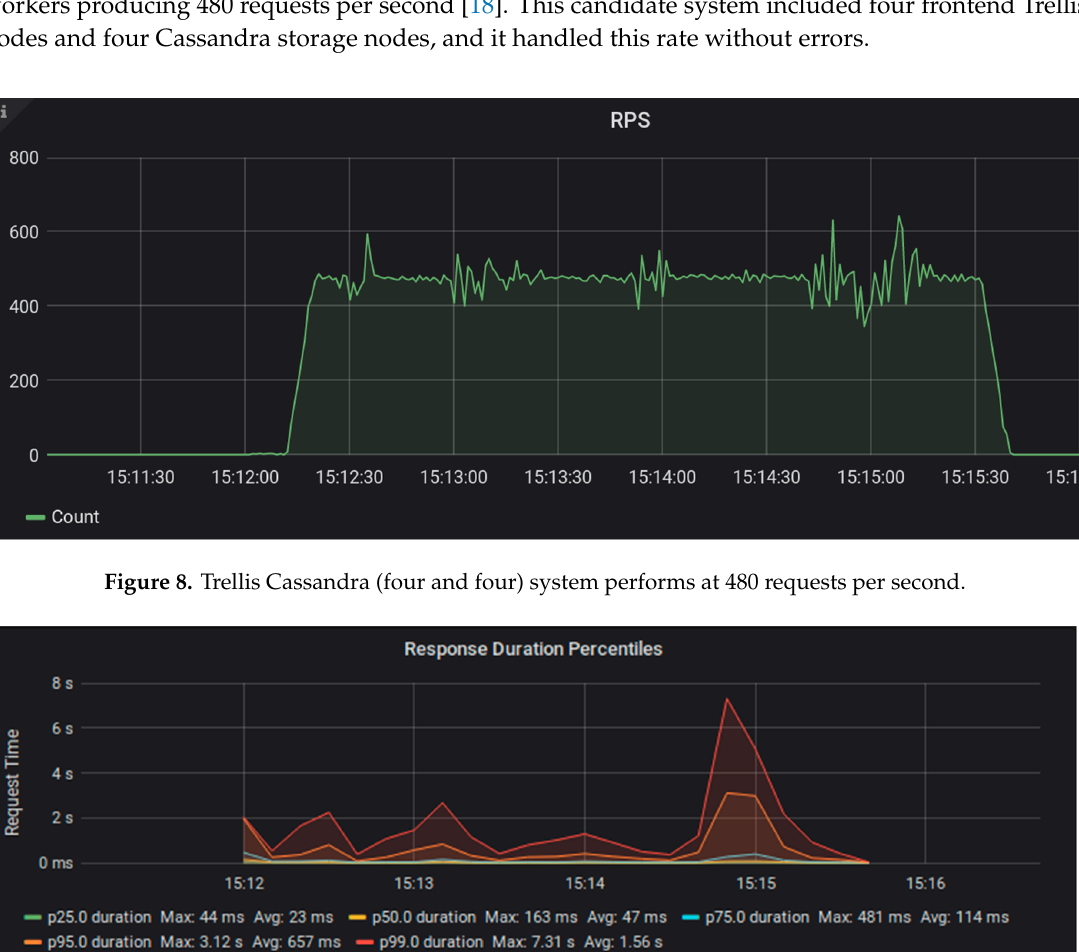
Figure 7. Trellis PostgreSQL performance degrades at 320 requests per second.